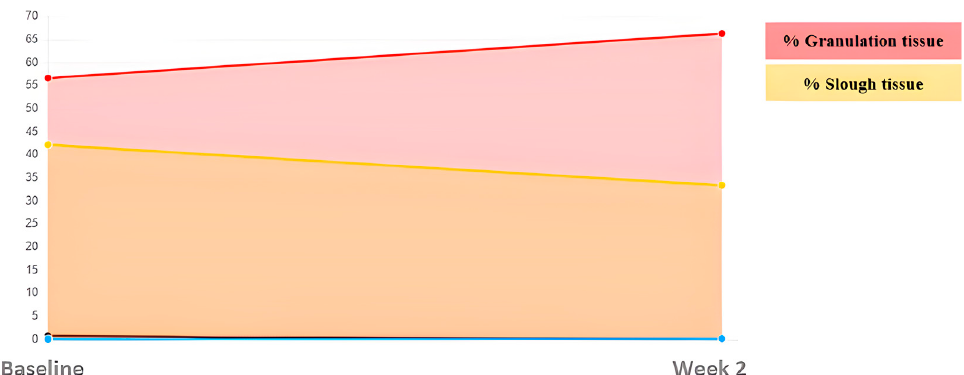
Figure 7. Healing evolution case 4: Baseline assessment ( left ), Baseline HELCOS analysis ( centre ), Week 4 assessment ( right ).